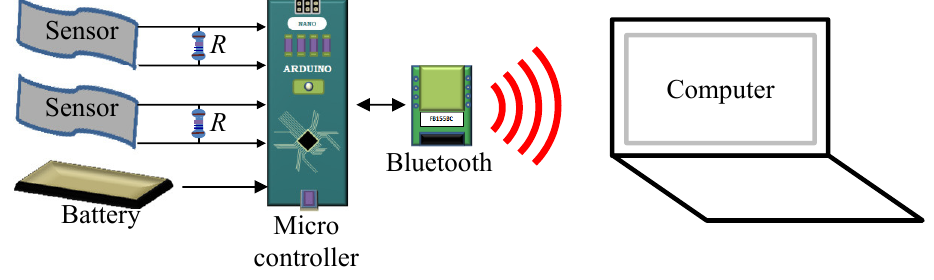
Figure 2. Schematic of the sensing system consisting of two flexible sensors and one sensing module.